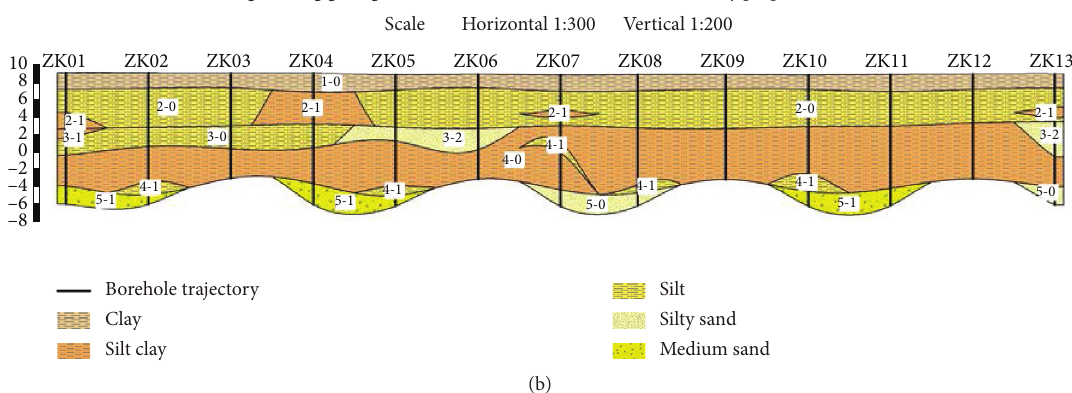
Figure 10: The engineering sections drawn by the proposed method in site scale: (a) section of 1st stratigraphical column and (b) section of 2nd stratigraphical columns. Table 3: The layer code of strata and its coarsen results on a regional scale. 1st stratigraphical